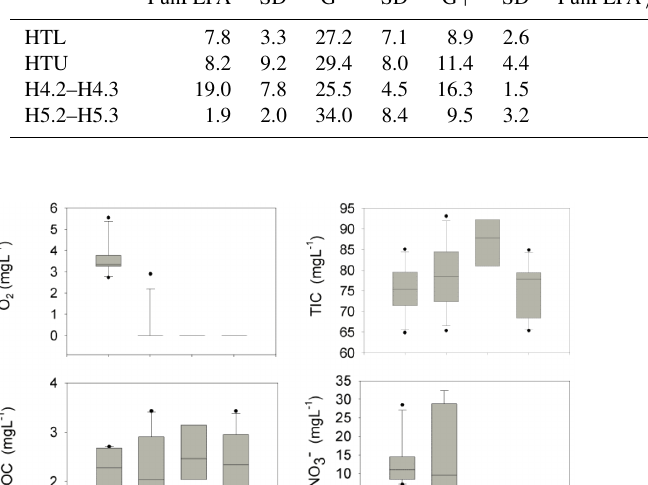
the 11Me16:0 (mean 4.2 ± 4.7 %) was found in high rela-